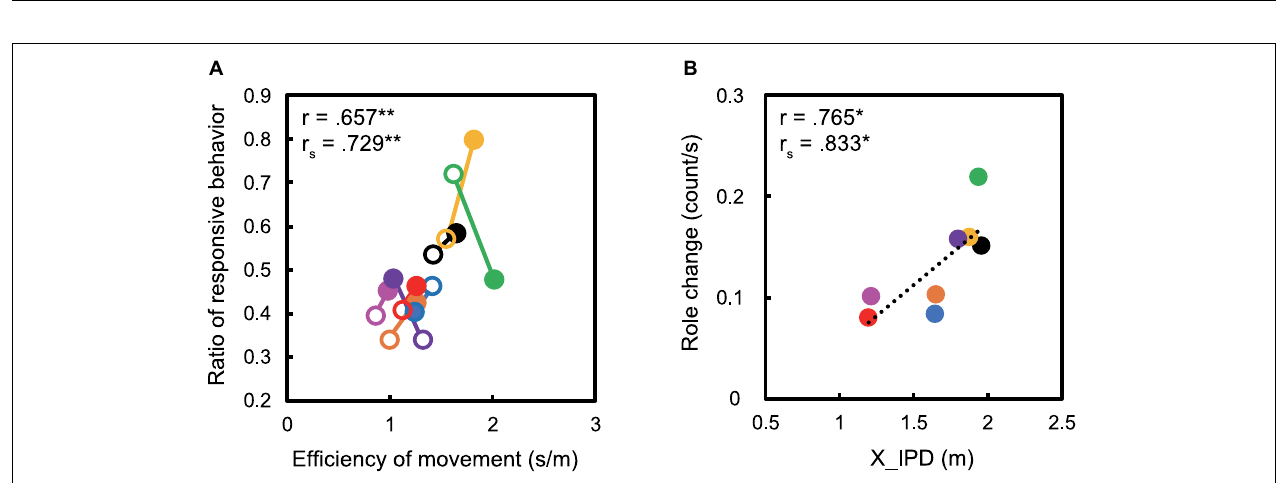
FIGURE 5 | Results of the pair activities in the math classes. Panel (A) illustrates the mean frequencies and standard deviations of the role changes for each pair. Panel (B) shows the ratio of the individual responsive behavior for each child. Panel (C) shows the relationship between role change and responsive behavior.